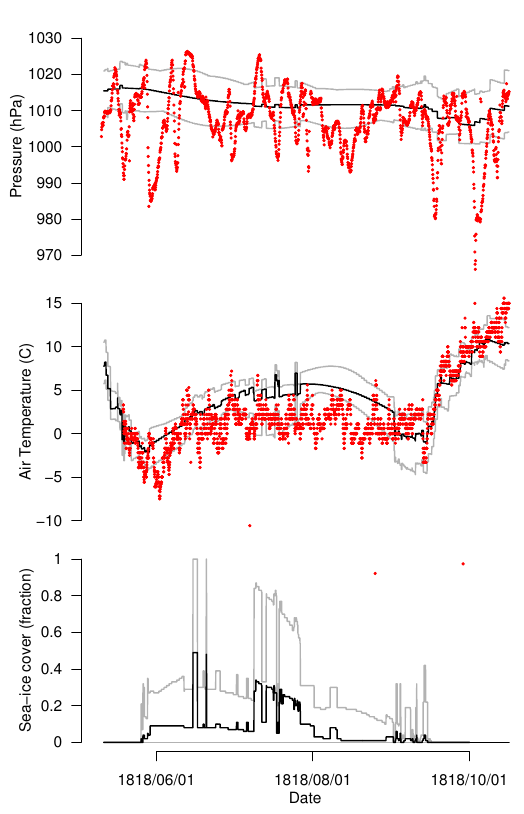
Fig. 4. Weather observations from HMS Dorothea , compared with modern values. The red points are the expedition’s observations, the blackandgreylinesarethemean, maxandminvaluesfrommoderndatasets(monthlyaveragesinterpolatedtodaily, 1979-2004; sea-ice fromRayneretal.(2003),ATfromRigoretal.(2000),andpressurefromAllanandAnsell(2006)).